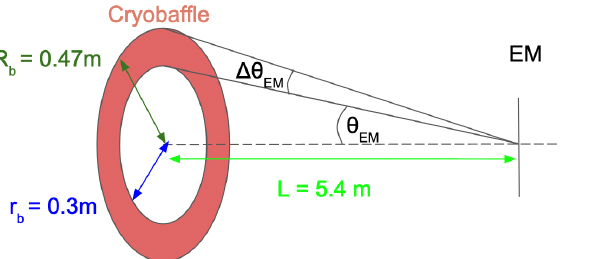
Figure 5. Solid angle from the EM in the direction of the cryobaffle. The distance between the EM and the cryobaffle is 5.4 m. The value of the solid angle is δ Ω EM ms = 0.0109